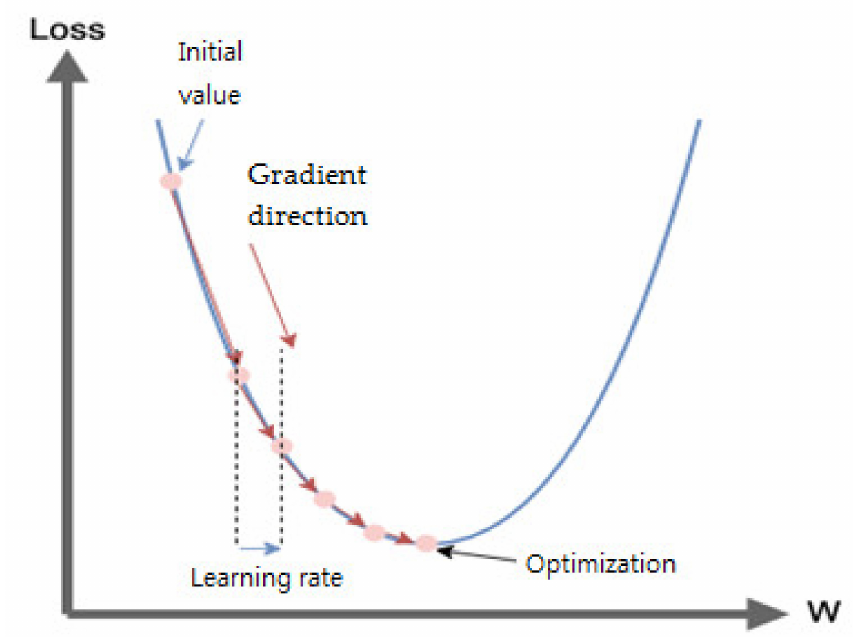
Figure 9. Gradient